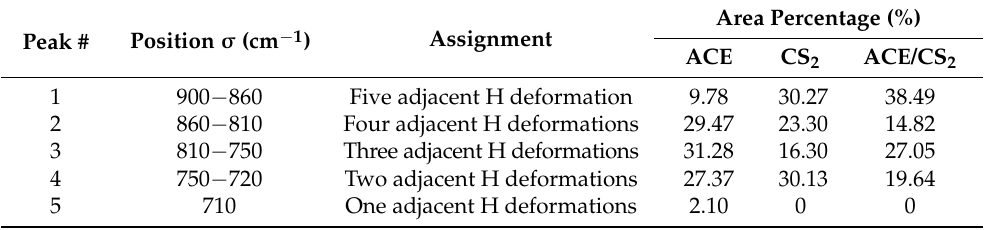
Figure 2. Infrared spectra of extracts in the 700–900 cm − 1 range. (( a ) is the carbon disulphide fit, ( b ) is the acetone fit and ( c ) is the mixed solvent fit. The red line is the fitted curve and the blue line is the sub peak). Table 2. Infrared spectra of three solvent extracts 700–900 cm − 1 split peak fi tt ing ratio of each absorption peak area.